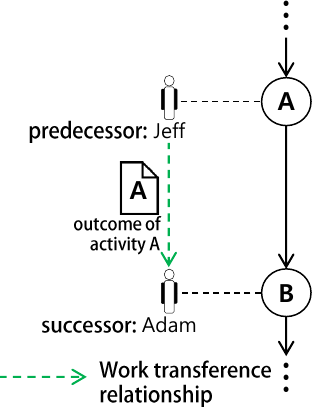
Figure 1. Concept of work transference